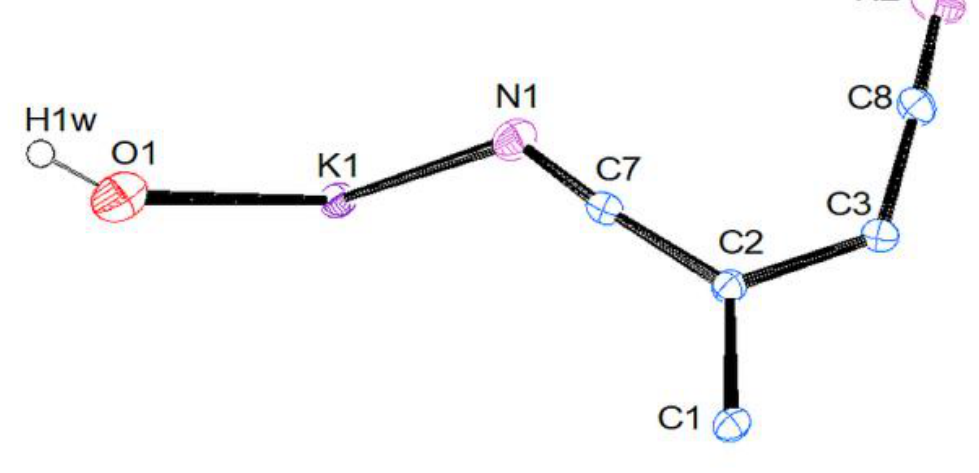
Figure 12. ORTEP 3 view of the asymmetric unit of 6a.